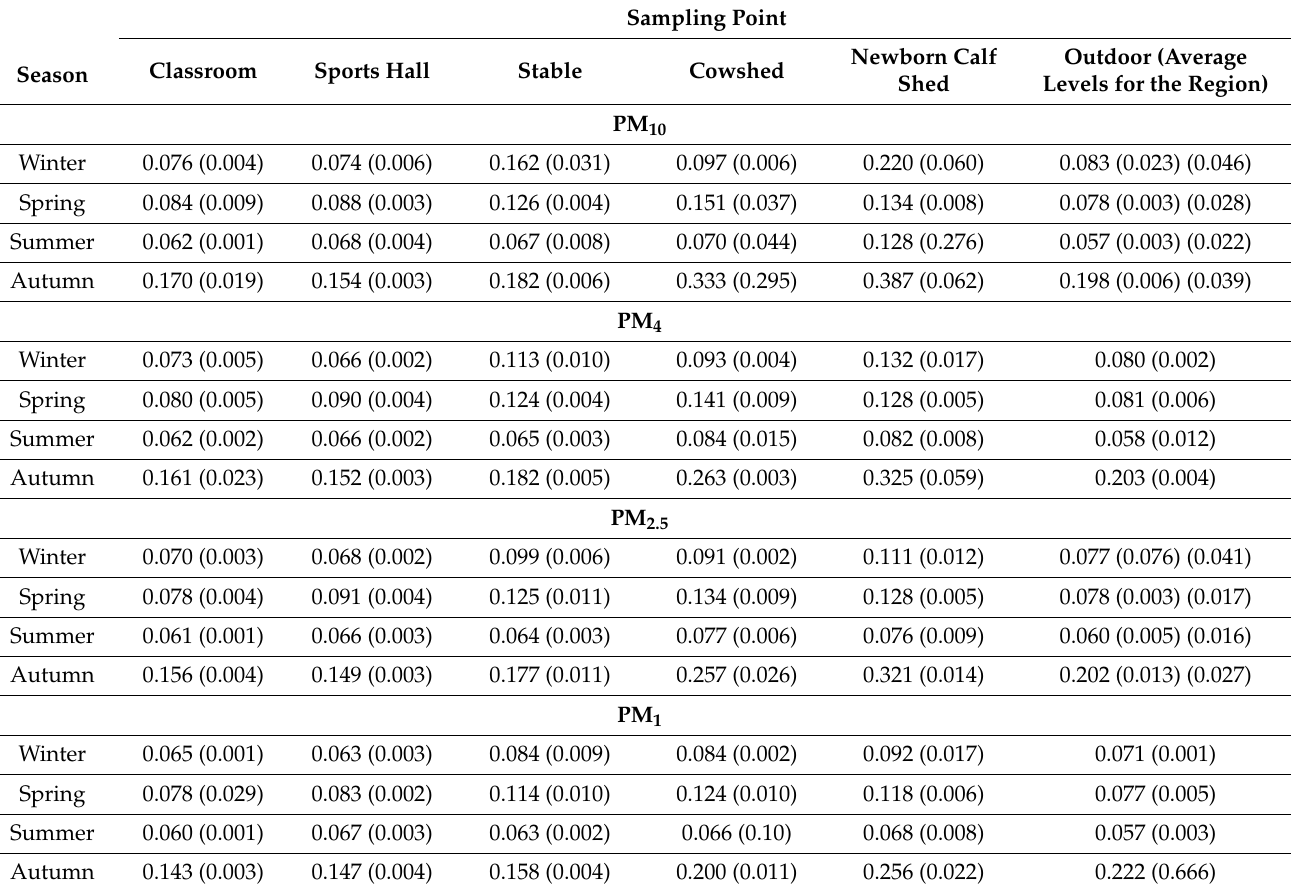
Table 2. Mean values of particulate matter concentration (mg/m 3 ) in the examined premises and outdoors. The presented values are means of three replicates. Values in brackets show standard